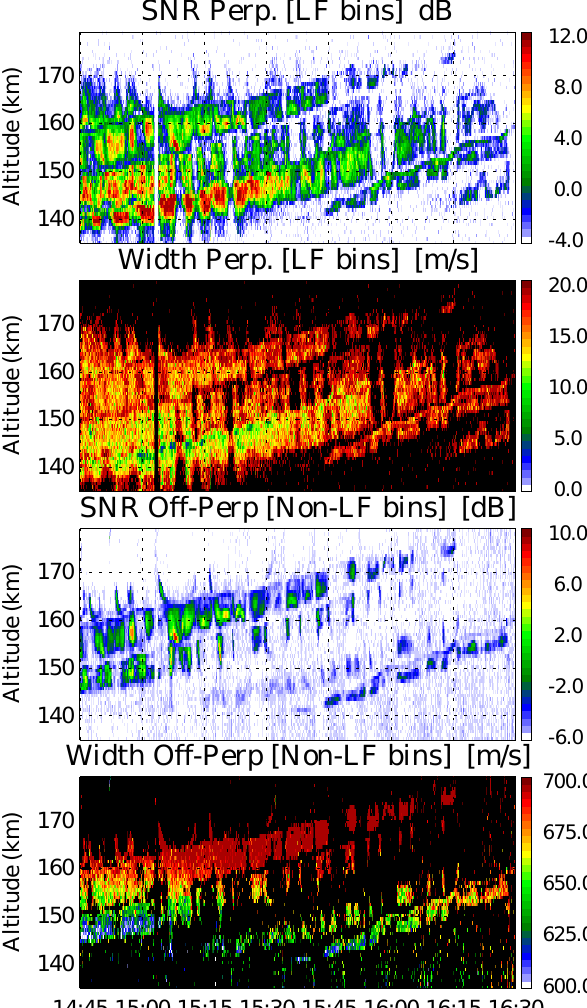
Fig. 5. Bistatic altitude-time contour maps for (a) perpendicular SNR, (b) perpendicular spectral width, (c) off-perpendicular SNR, and (d) off-perpendicular spectral width for data taken on 3 April 2008. For the perpendicular plots, only low-frequency bins are used, while for the off-perpendicular plots the low-frequency bins are not